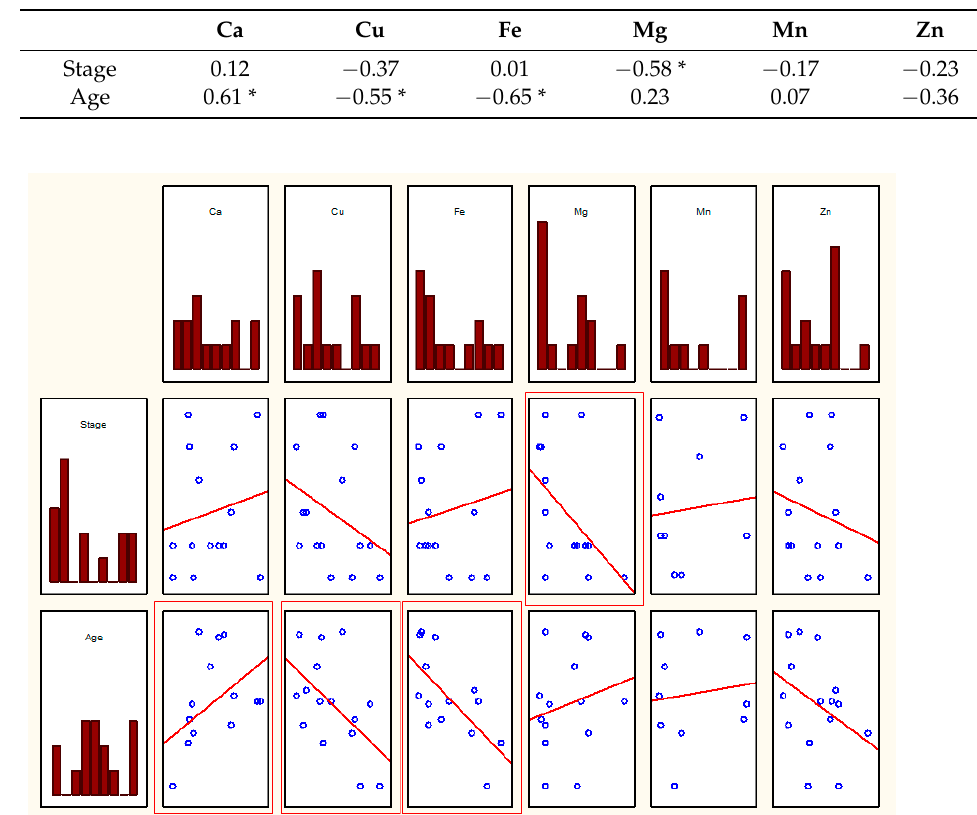
Figure 5. Scatterplot for pairs of elemental parameters considering age and stage of atherosclerosis in men. Thin frame— p < 0.05. Table 4. The values of the correlation coefficients for the content of analytes in the tissue of men considering age and stage of atherosclerosis. Statistically significant values are marked with an as ‐